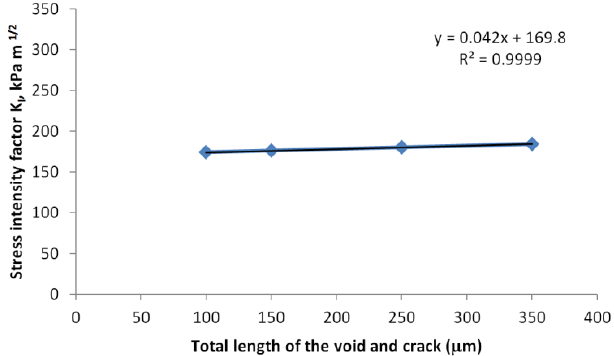
Figure 15. Effect of crack lengths on intensity factor.